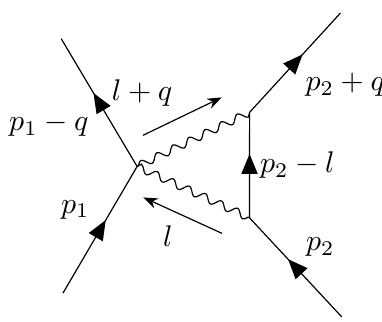
Figure 1 . The only topology contributing classical tidal effects at one loop. Here, the tidal effects of particle 1 are probed. The wavy lines represent either photons or